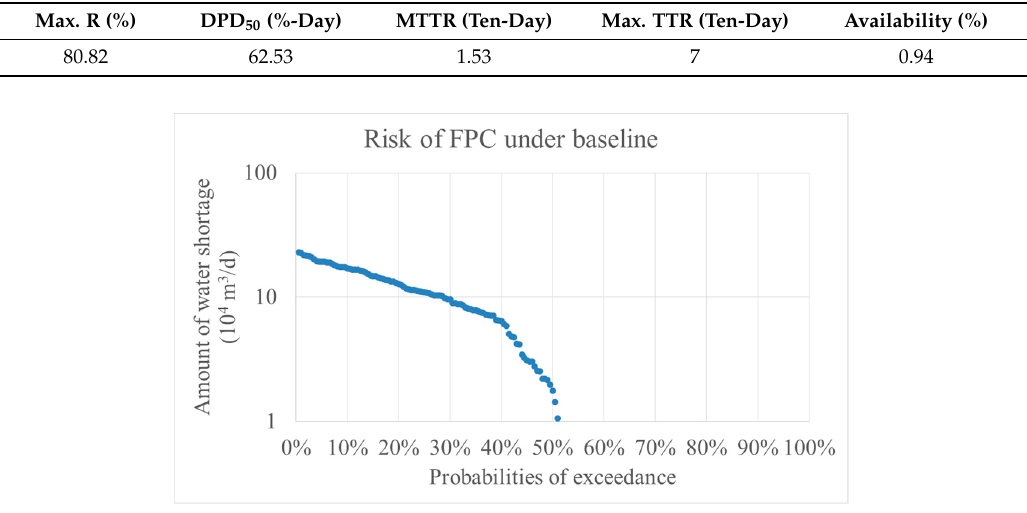
Figure 6. Probabilities of exceedance of the annual maximum water shortage amounts on a logarithmic axis.